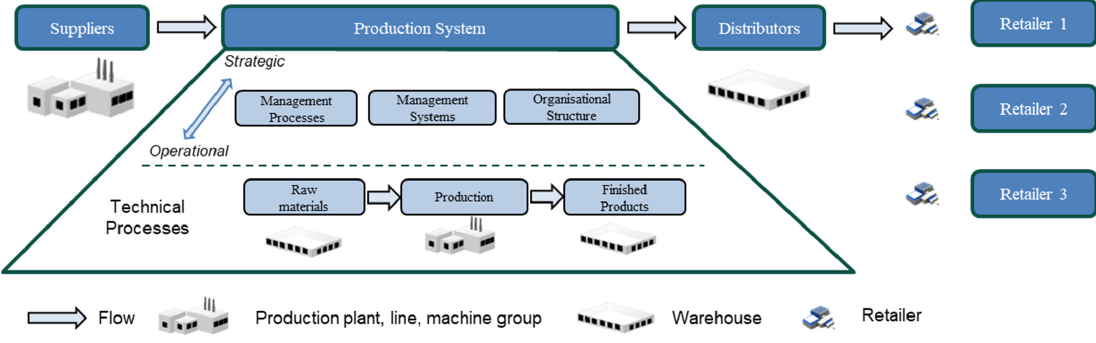
Figure 9. Structure of the simulation case study [61].